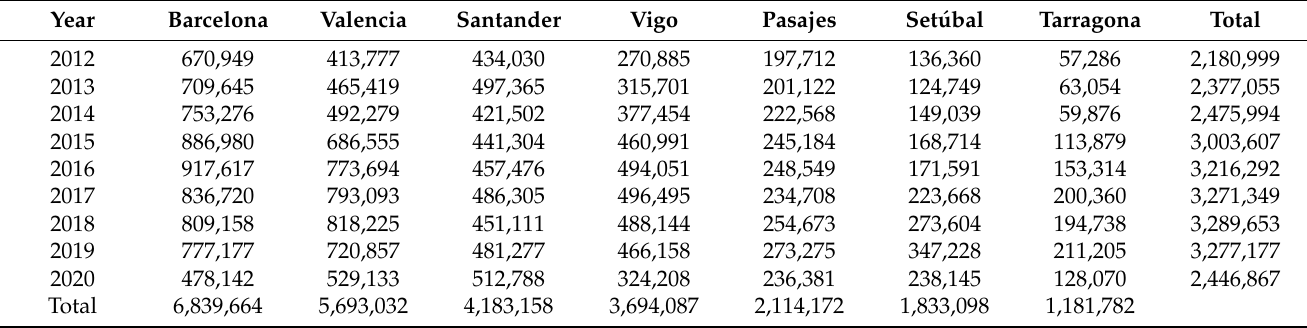
Table 1. Vehicle movements during the period 2012–2020 in the ports of the Iberian Peninsula with PCC/PCTC ship traffic.